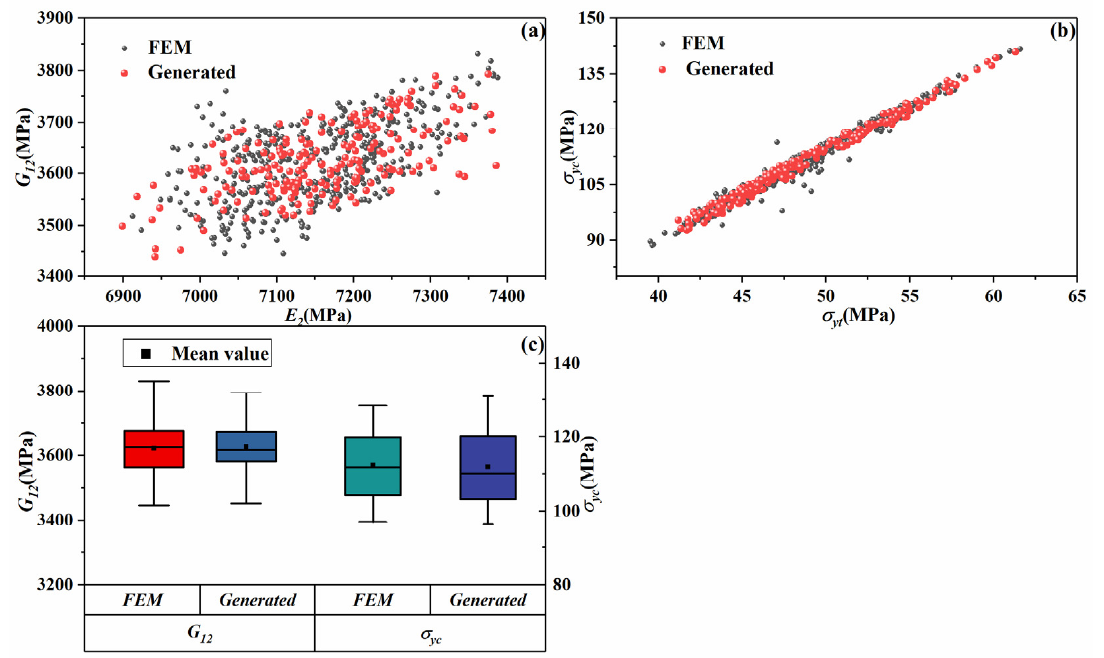
Figure 11. Distributions of calculated and generated mechanical properties. ( a , b ) represent the examples of calculated and generated results; ( c ) shows the distributions of two mechanical properties.